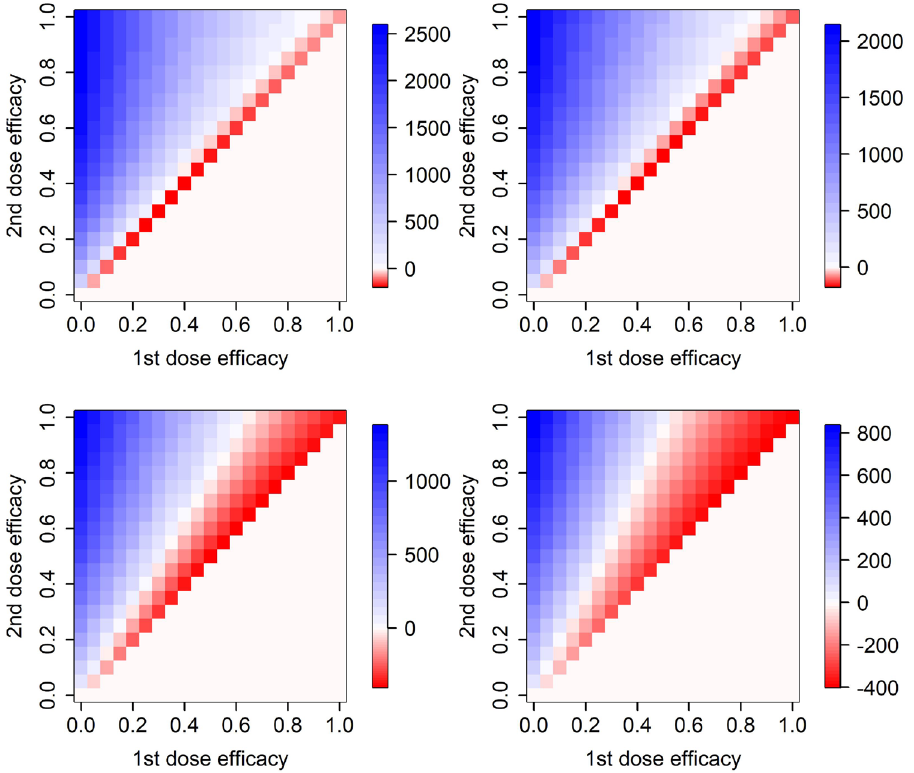
Figure 7. Efficacy of delaying the second vaccine dose by 3 weeks from 21 to 42 days, assuming vaccine effect on the probability that a vaccinated person gets infected by contact with an infectious one, and at the same time on the probability that a vaccinated person becomes symptomatic when infected. Top left: twice more doses available, top right: actual state in Czechia, bottom left: twice less doses available, bottom right: four time less doses available. Only model H is used